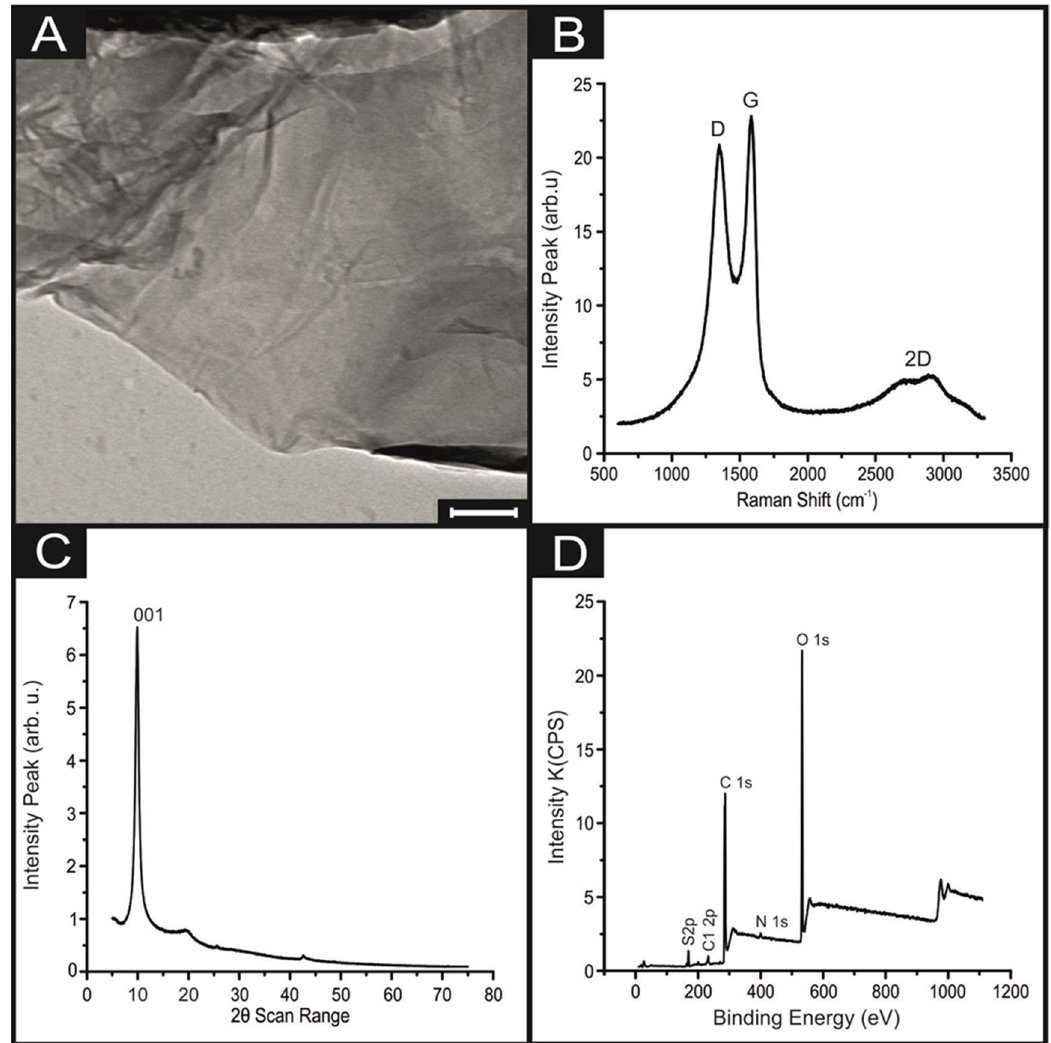
Figure 1. Characterisation of the commercially sourced GO; (A) image of the GO nanosheet (Scale bar: 100 nm), (B) Raman spectra of GO deposited onto a silicon wafer between 100 and 3400 cm, (C) X-ray diffraction (XRD) spectra between 5 and 75 2 θ , and (D) high-resolution XPS survey spectra.